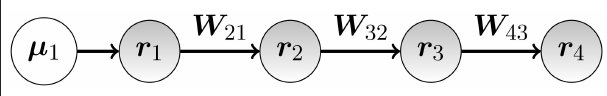
FIGURE 1 | Sketch of a four-population feed-forward neural model defined via connection matrix in Equation (11)